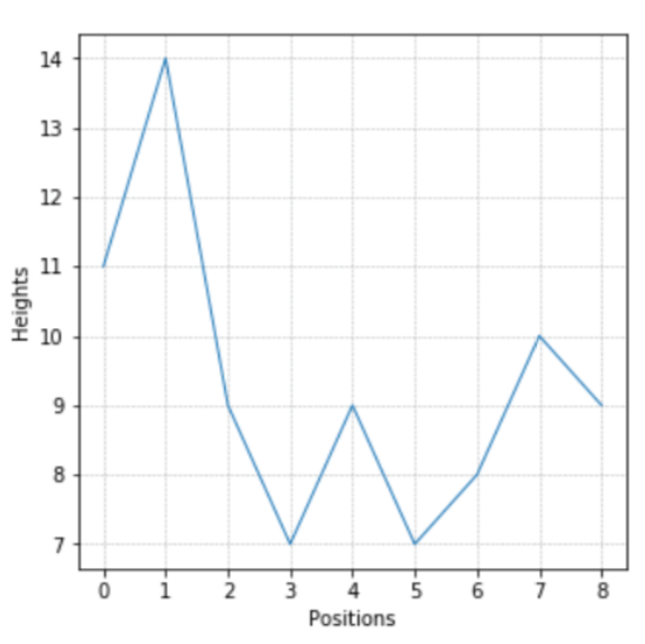
Figure 6. The map f X for X = ( 11,14,9,7,9,7,8,10,9 ) .